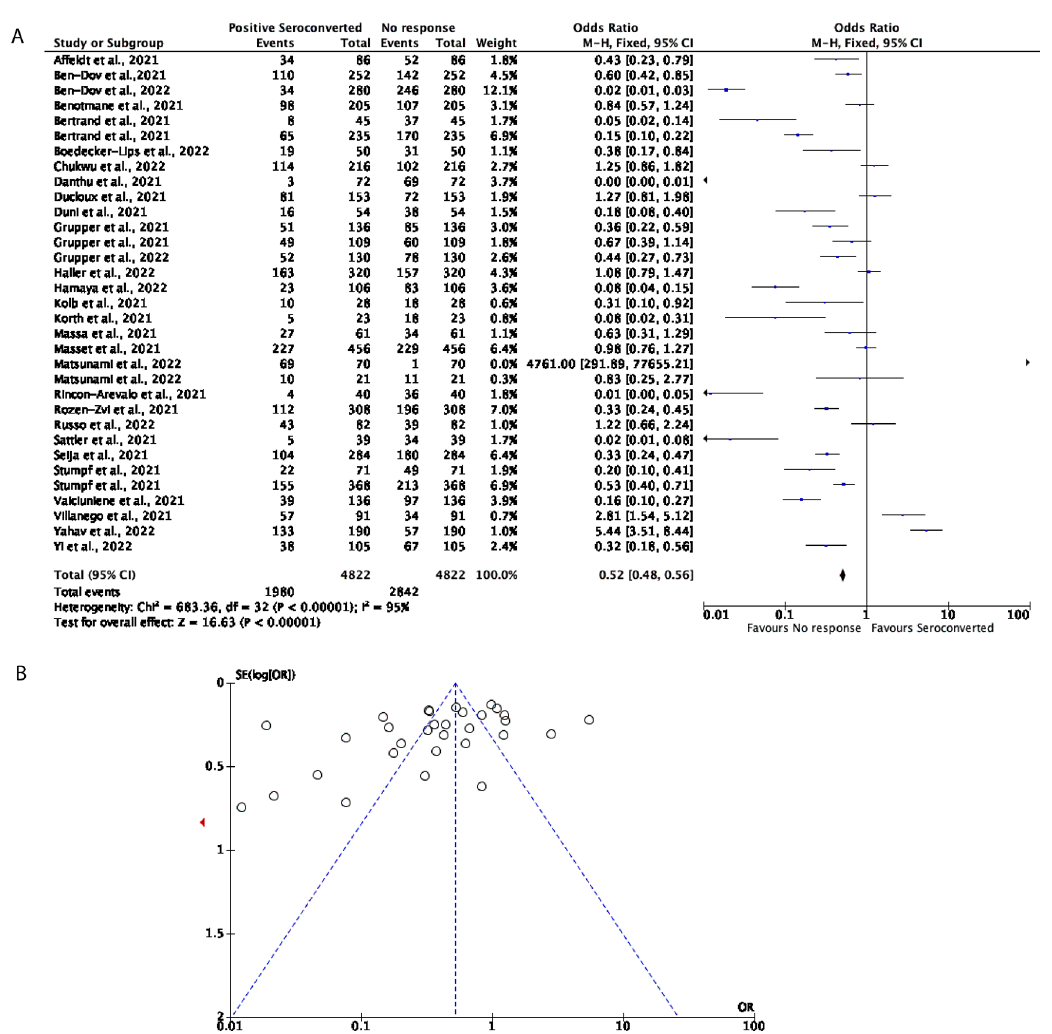
Figure 3. Only 41% of Kidney Transplant Recipients (KTRs) seroconvert after receiving a COVID-19 mRNA vaccine. (A)ForestplotcomparisonofthenumberofKTRswhoseroconvertedorhadnoresponseaftertwodosesof an mRNA vaccination (OR = 0.52, 95% CI = 0.48-0.56, P <0.00001, I 2 = 95%). (B) Funnel plot evaluating heterogeneity when comparing seroconversion response in KTRs after two doses of an mRNA vaccine. Significant heterogeneity was observed ( P <0.00001, I 2 =